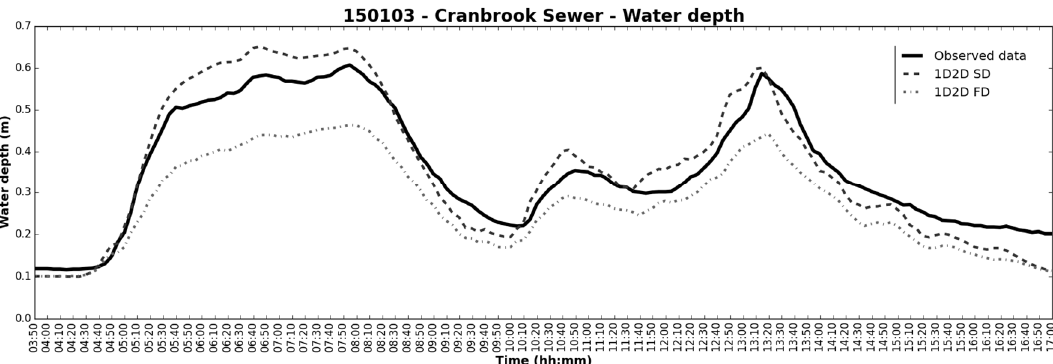
Figure 8. Predicted flow and observed data in the Barkingside gauge for Event 150103—Cranbrook case study.